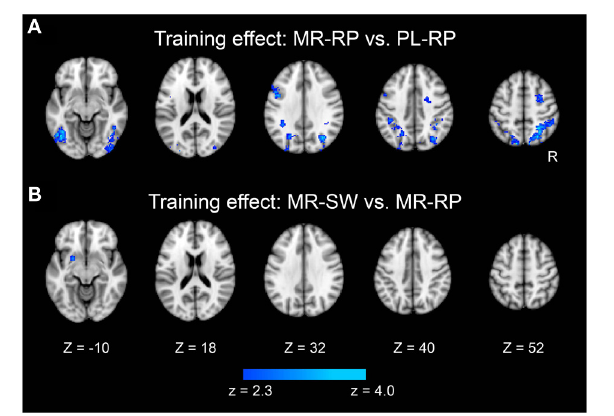
FIGURE 4 | Statistical significance maps for training-related decreases in the contrasts Mirror-Repeat minus Plain-Repeat (A) and